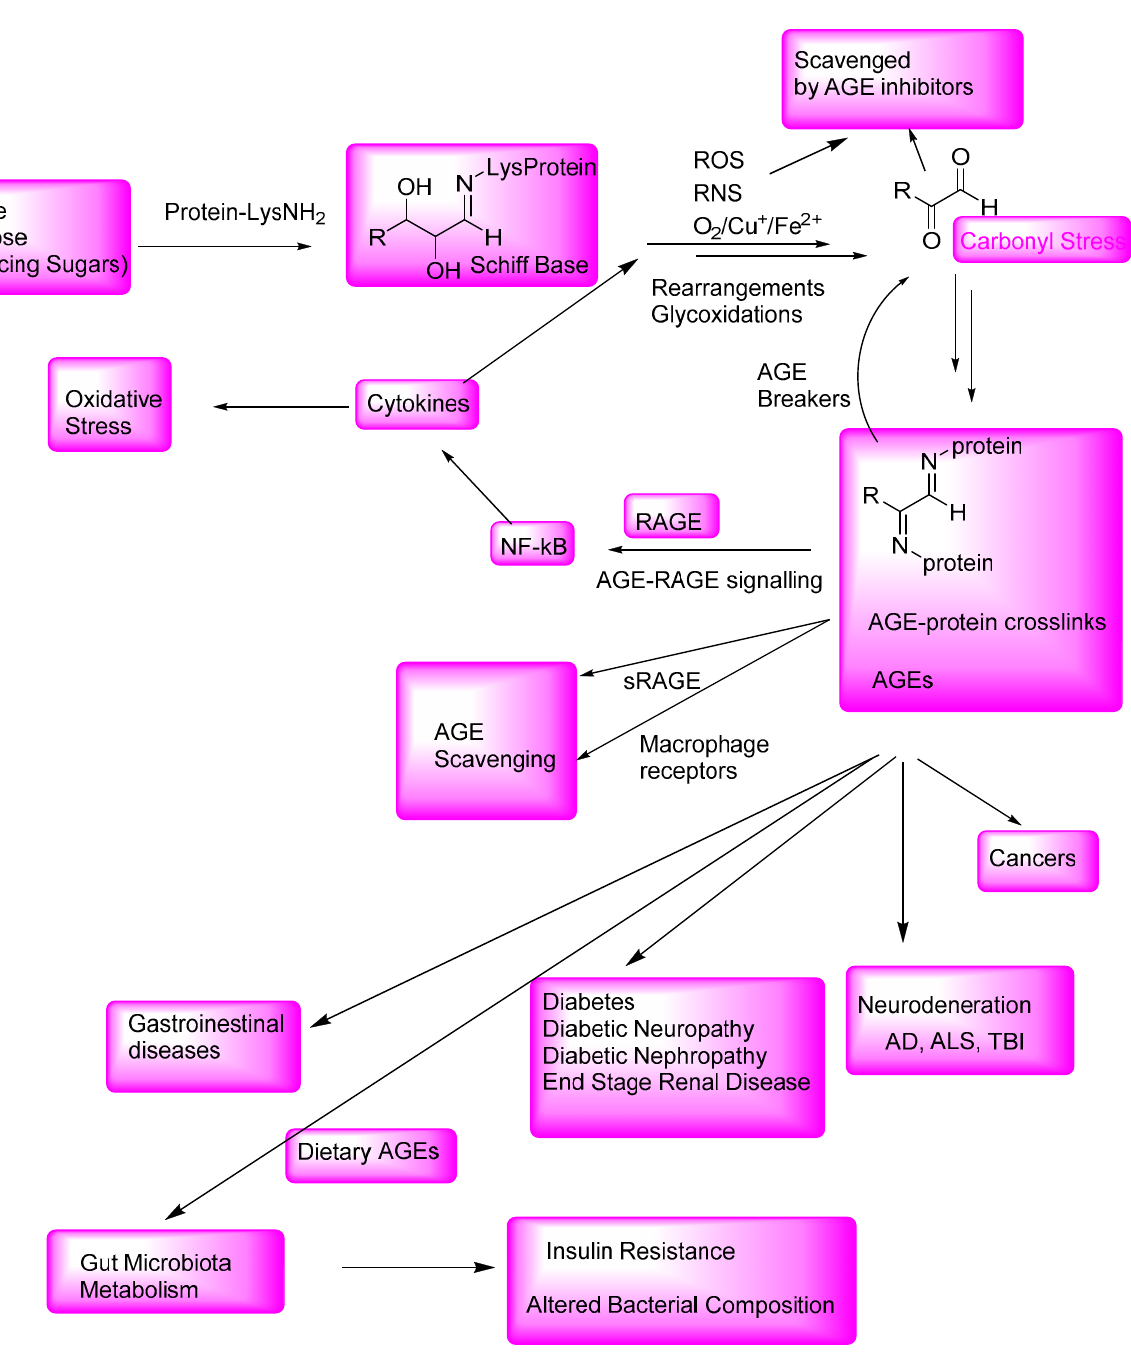
Figure 13. Schematic outline summarizing the formation of AGEs, AGE inhibitors, and AGE breakers, AGE-RAGE interactions, and the onset and exacerbation of various AGE-related diseases. AGE protein crosslinks and small-molecule AGEs, including dietary AGEs, through AGE-RAGE interactions, are involved in the onset and exacerbation of various AGE- related gastrointestinal diseases and neurological disorders, such as AD and TBI-associated AD-related dementia (ADRD). The dietary and endogenously formed AGEs affect the gut microbiota composition and insulin resistance. In addition to the binding to the RAGE, AGEs also bind to the cell surface receptors of macrophages and other AGE-specific receptors and are thereby degraded to nontoxic